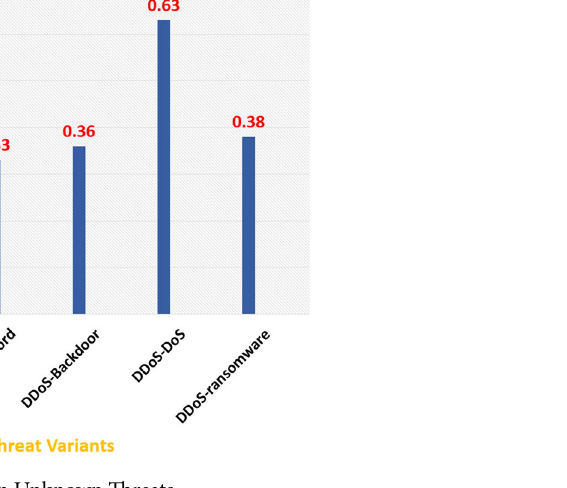
Figure 8. Correlation between Unknown